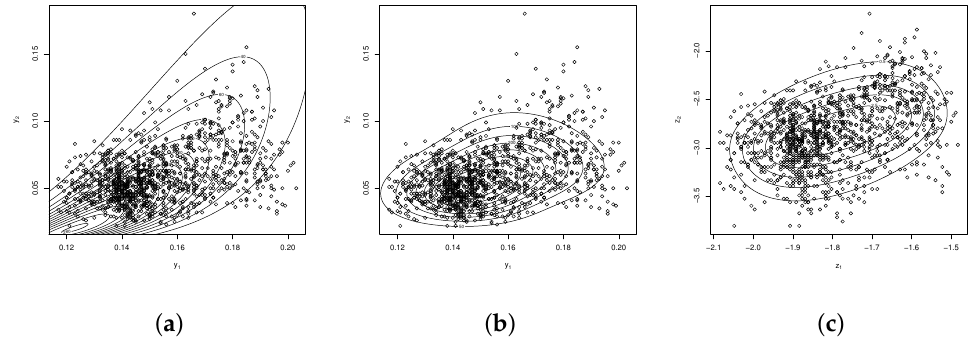
Figure 3. Contour plots for the fitted models. ( a ) VBJSB, ( b ) VBBeta, and ( c )